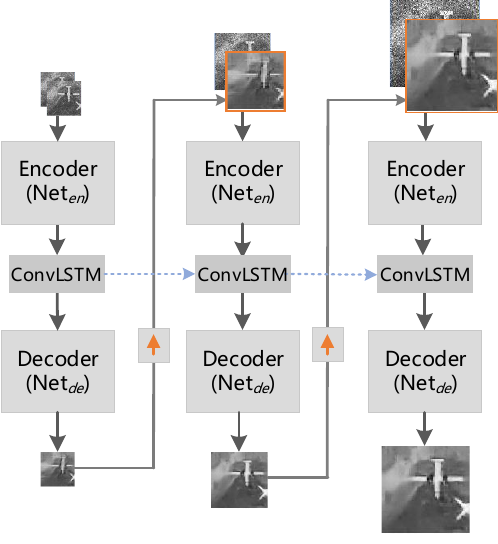
Figure 2. The architecture of Multi-scale Recurrent. The yellow arrow denotes up-sampling by one